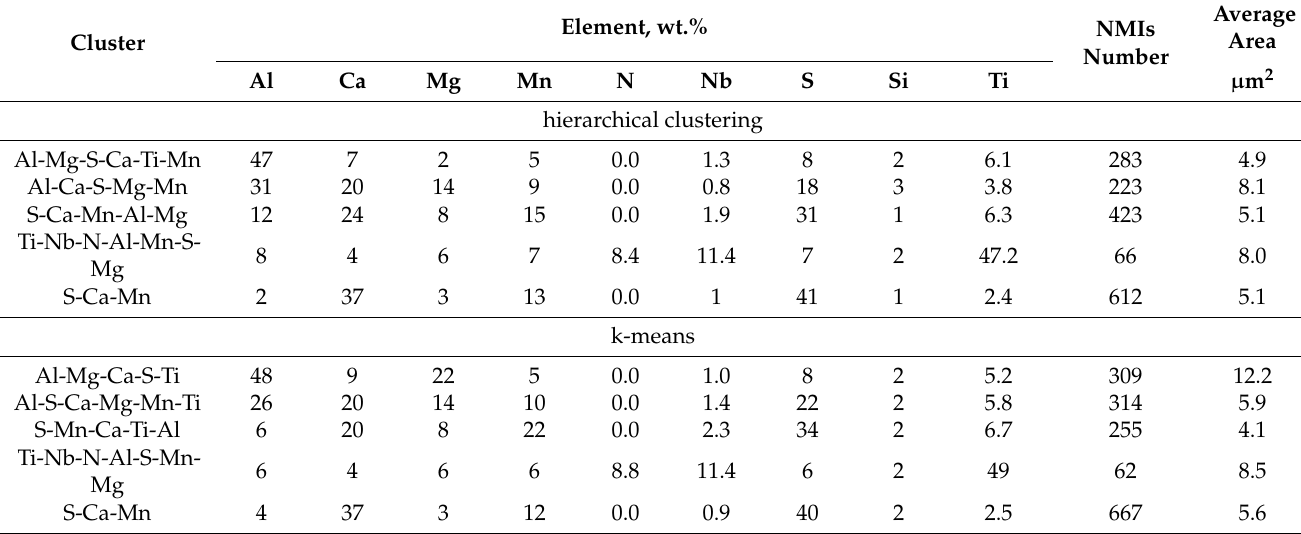
Table A2. Results of clustering by different methods in steel X70.